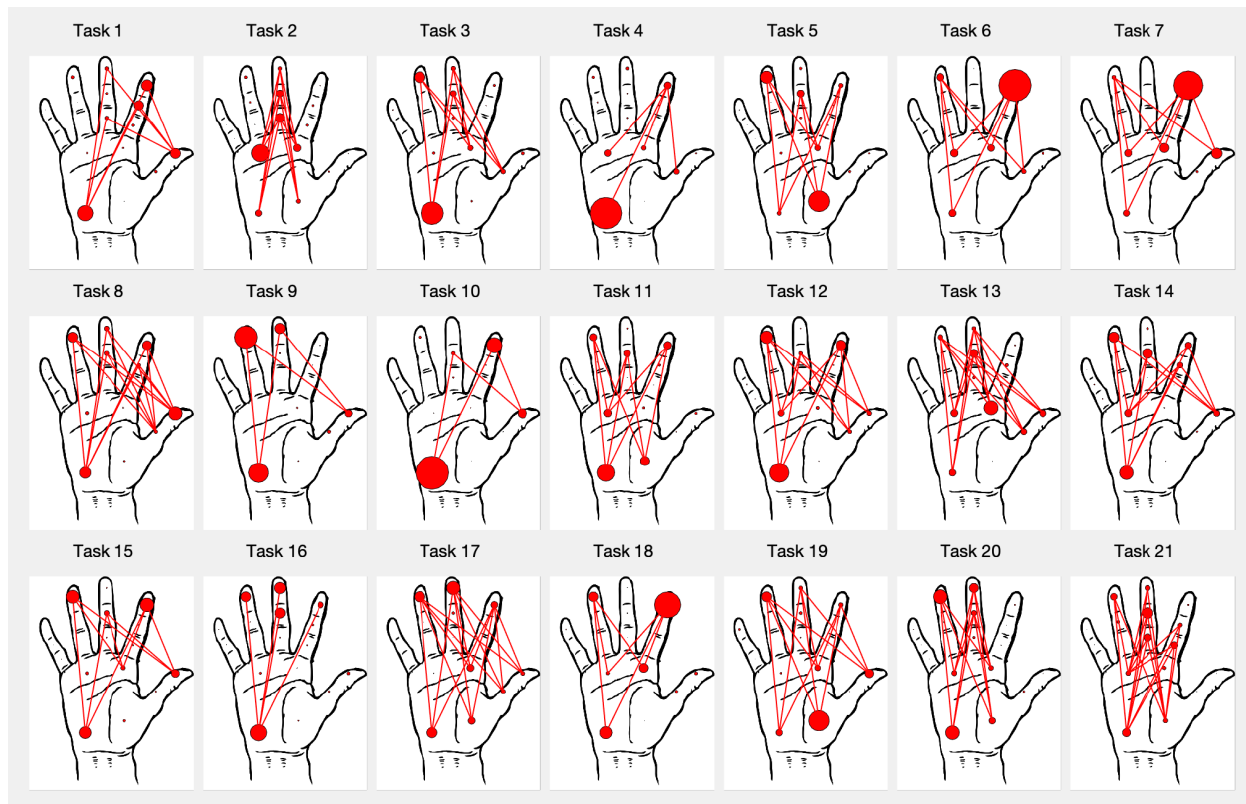
Figure 8. Characteristic pattern for each task in the mean contribution to grip force (CGF) for the different sensing regions, averaged among subjects. Circle sizes are proportional to the regions CGF and lines connect regions of the fingers with other regions of the thumb or palm, if CGF for both regions is greater than 5%.